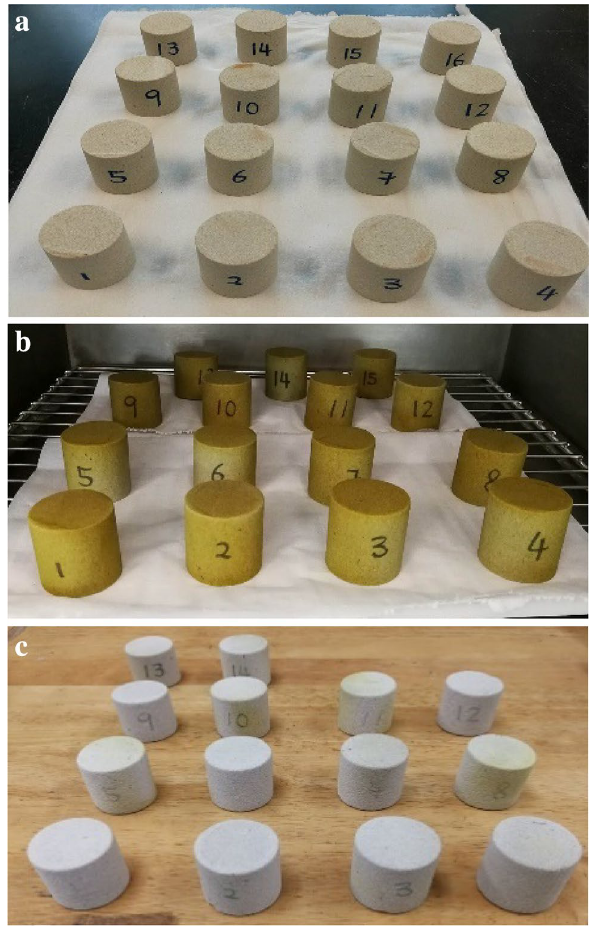
Fig. 1 The colour of the core sample ( a ) at initial condition, b after saturating with preflush, c after saturating with emulsified